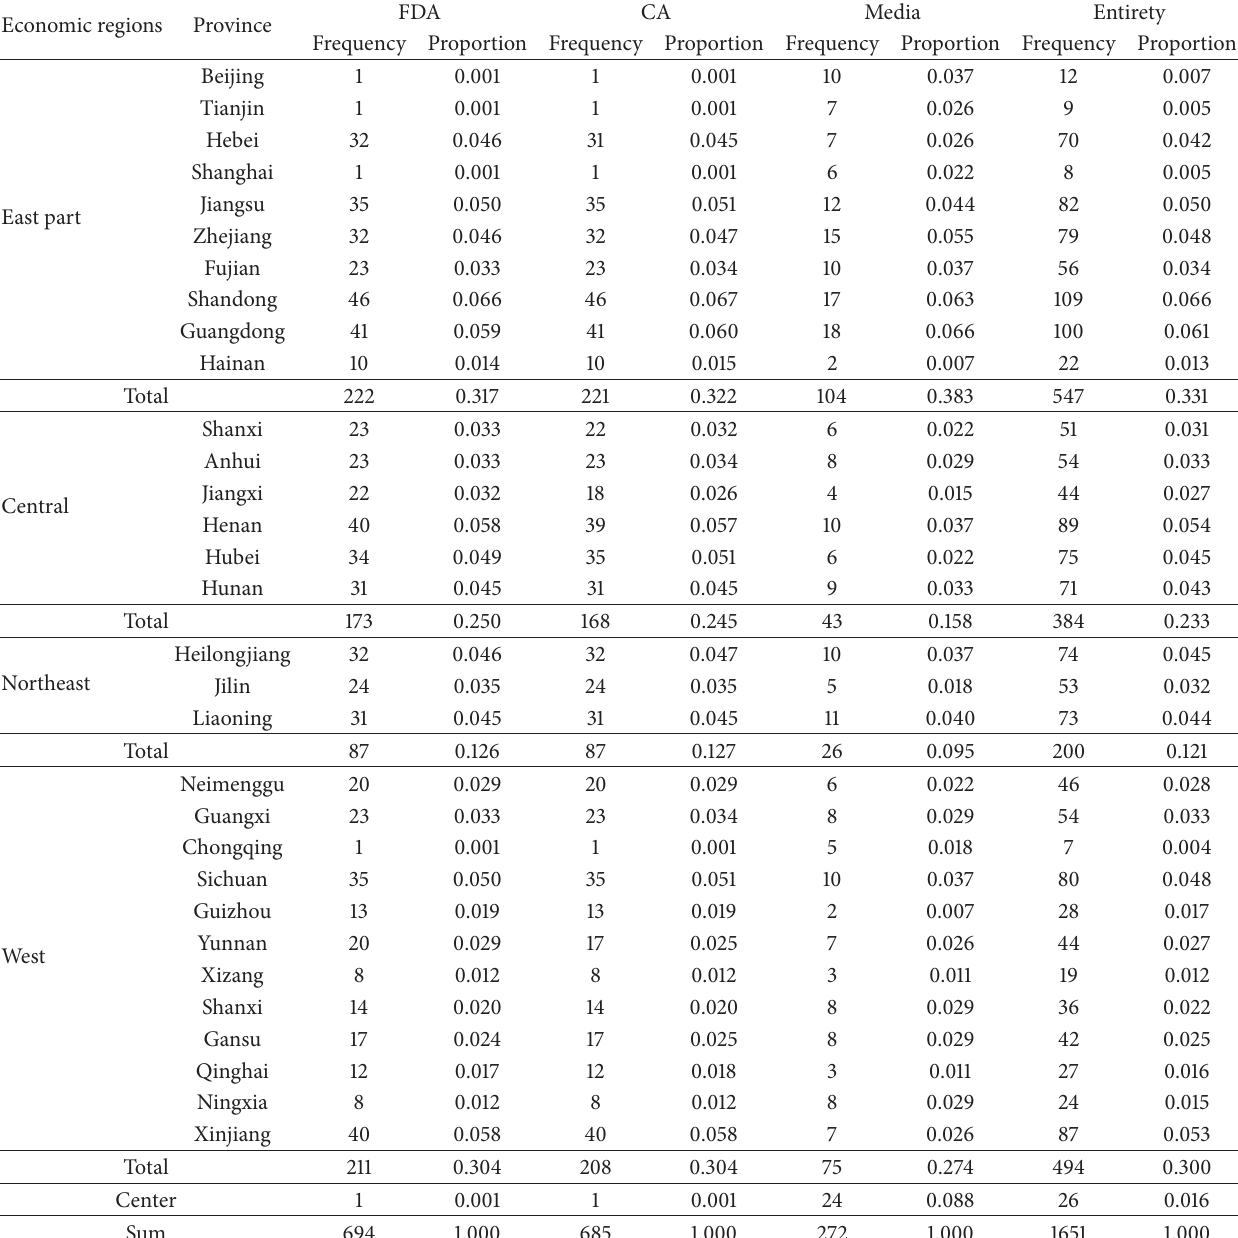
Table 6: Characteristics of different economic